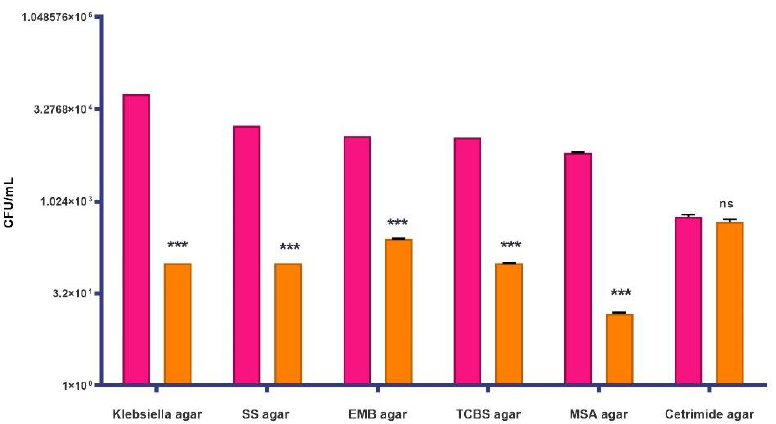
Figure 6. Effect of ACF on the reduction of enteric pathogens in wastewater. The raw wastewater treated with ACF in a 1:1 ratio served as test and the untreated wastewater served as control. The reduction of enteric pathogens was determined by CFU enumeration in selective and differential media ( Klebsiella agar , SS agar- Salmonella Shigella agar, EMB agar- Eosin Methylene blue agar, TCBS – Thiosulfate citrate Bile Salts sucrose agar, MSA-Mannitol Salt agar) after 24 h of incubation. Values are means ± standard deviation of three replicates. Two-way ANOVA (analysis of variance) followed by Sidak’s multiple comparison test *** p < 0.001, ns- not significant.